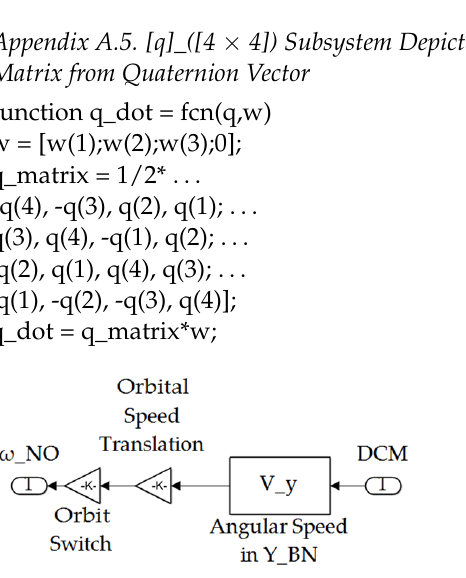
Figure A12. DCM subsystem depicted in Figure A1.